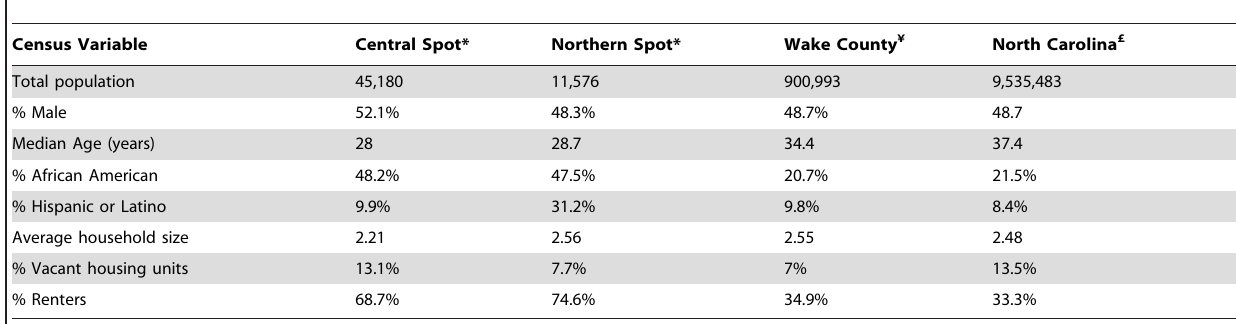
Table 2. Sociodemographic Characteristics of General Population in Study Areas, Wake County, and North Carolina.